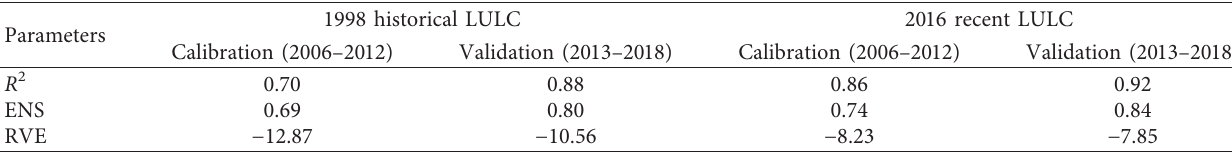
Figure 17: Sediment flow comparison for validation periods (a) 1998 LULC and (b) 2016 LULC. Table 15: Measures of model performance for sediment.